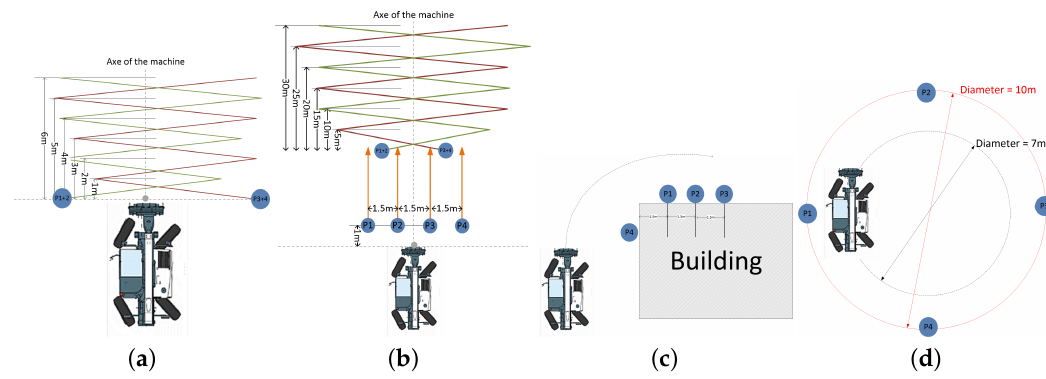
Figure 19. Diagram of the scenarios from the heavy machine dataset: machine stationary ( a ); machine moving forward ( b ); and machine turning ( c , d ).